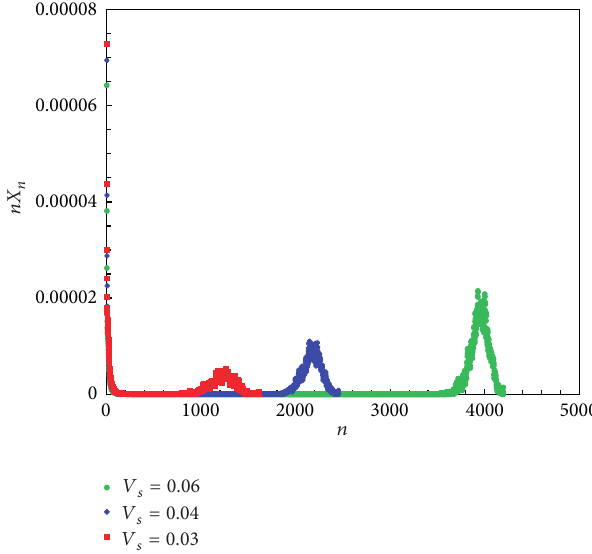
F 11: Same as Figure 9 but for